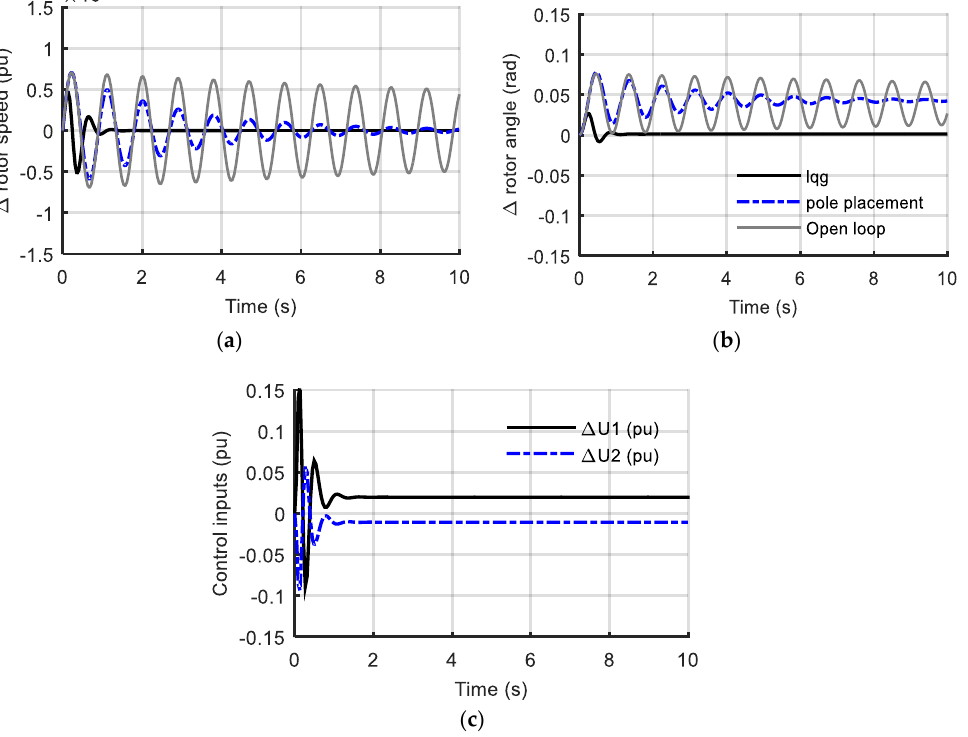
Figure 4. SG performance due to 0.05 pu step load demand at P = 1 pu, Q = 0.25 pu. ( a ) rotor speed deviation; ( b ) rotor angle deviation; ( c ) LQG control vector inputs.